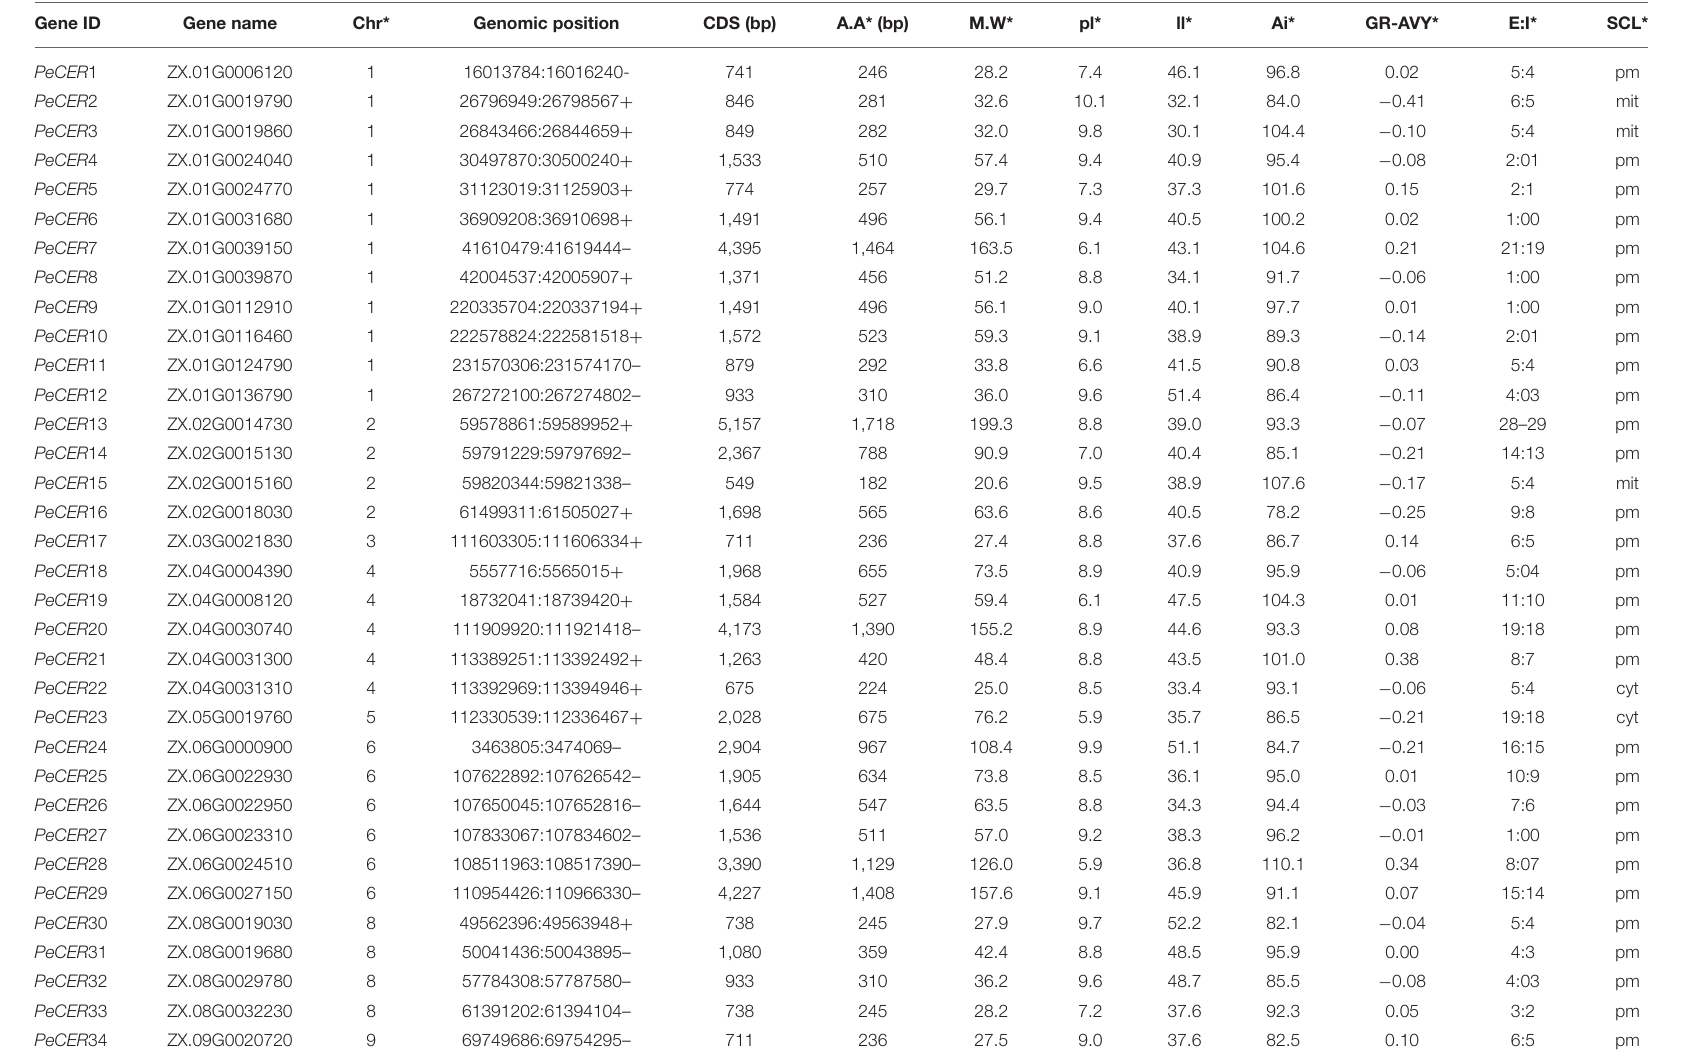
TABLE 1 | Physicochemical features of PeCER